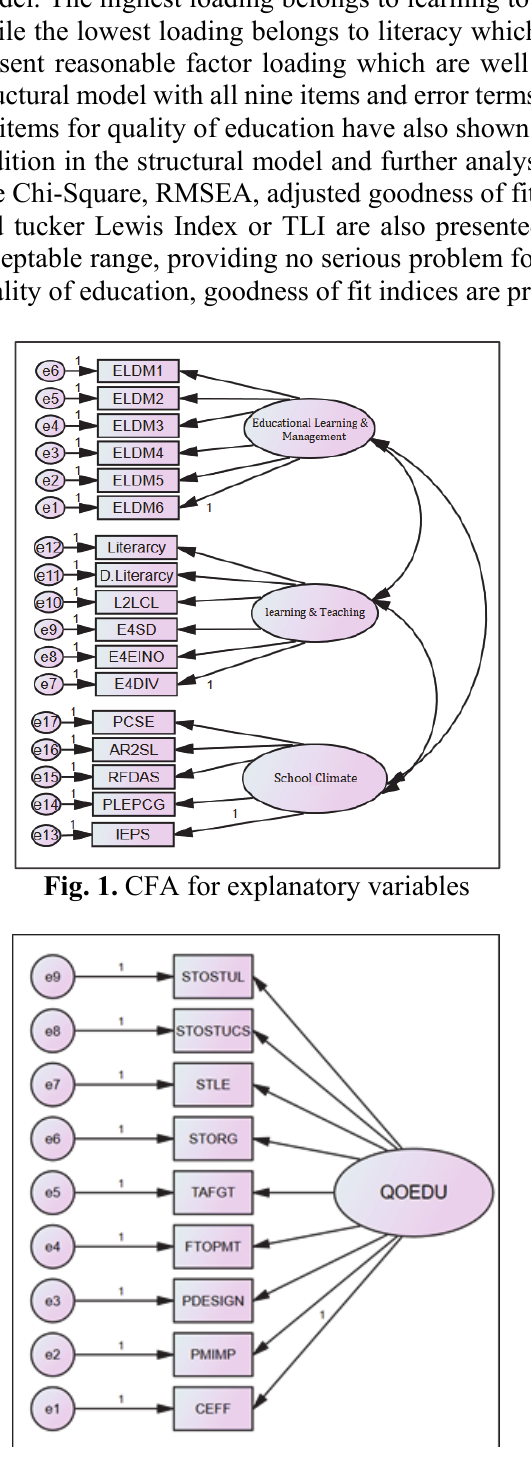
Fig. 3. CFA for outcome variable Fig. 4. Factor Loadings for explanatory